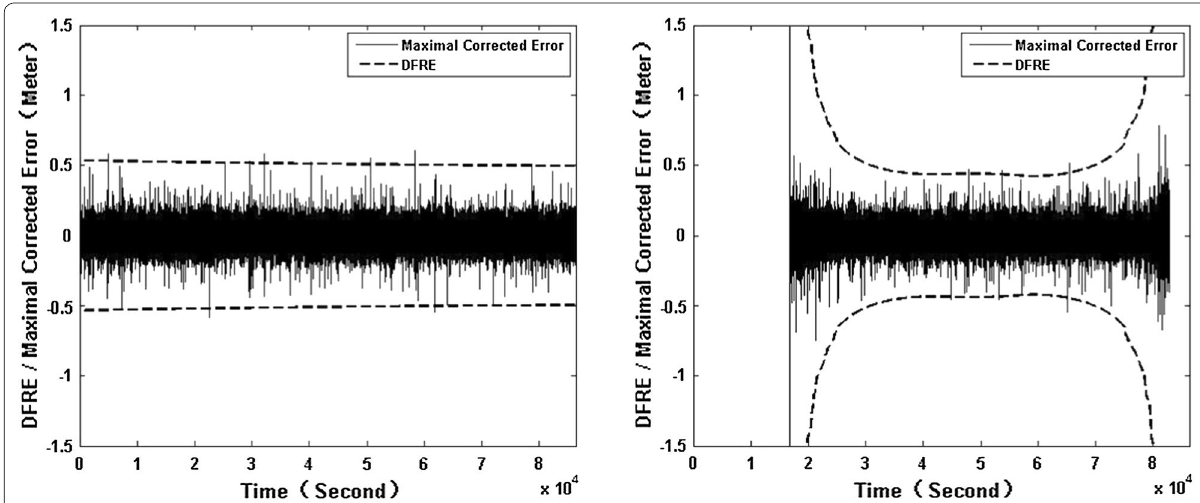
Fig. 3 DFRE versus maximal corrected error of BDS GEO2 (left) and BDS IGSO3 (right)